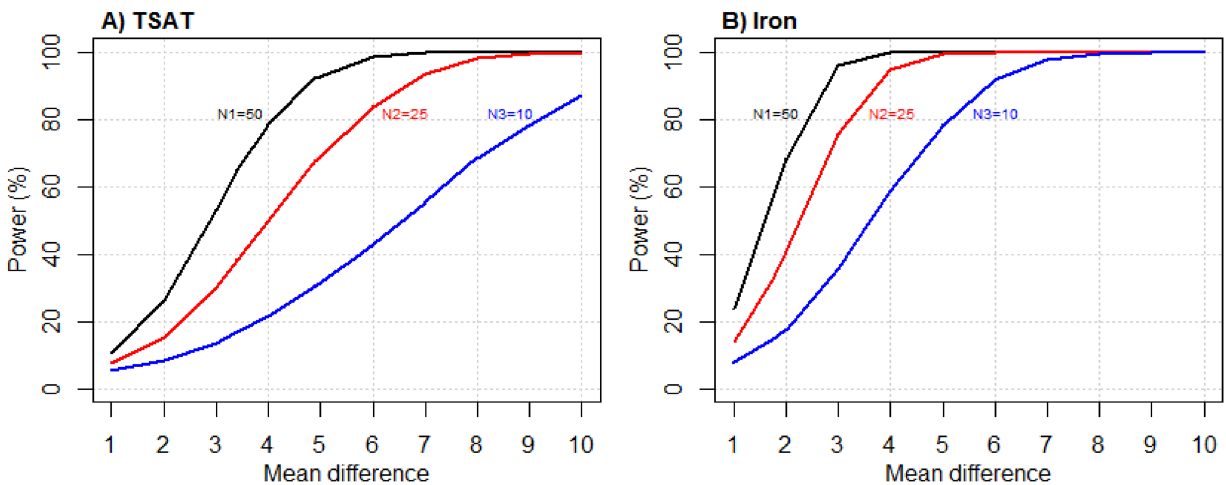
Figure 3. Estimated power to detect a given difference between Groups A vs D based on simulation using a linear regression model adjusted for baseline for three sample size scenarios. N1 (Group A=Group B=Group C=50 neonates); N2 (Group A =Group B =25 neonates and Group C=50 neonates); N3 (Group A =Group B =10 neonates and Group C=50 neonates); N4 (Group A =Group B=50 neonates and Group C =10 neonates).